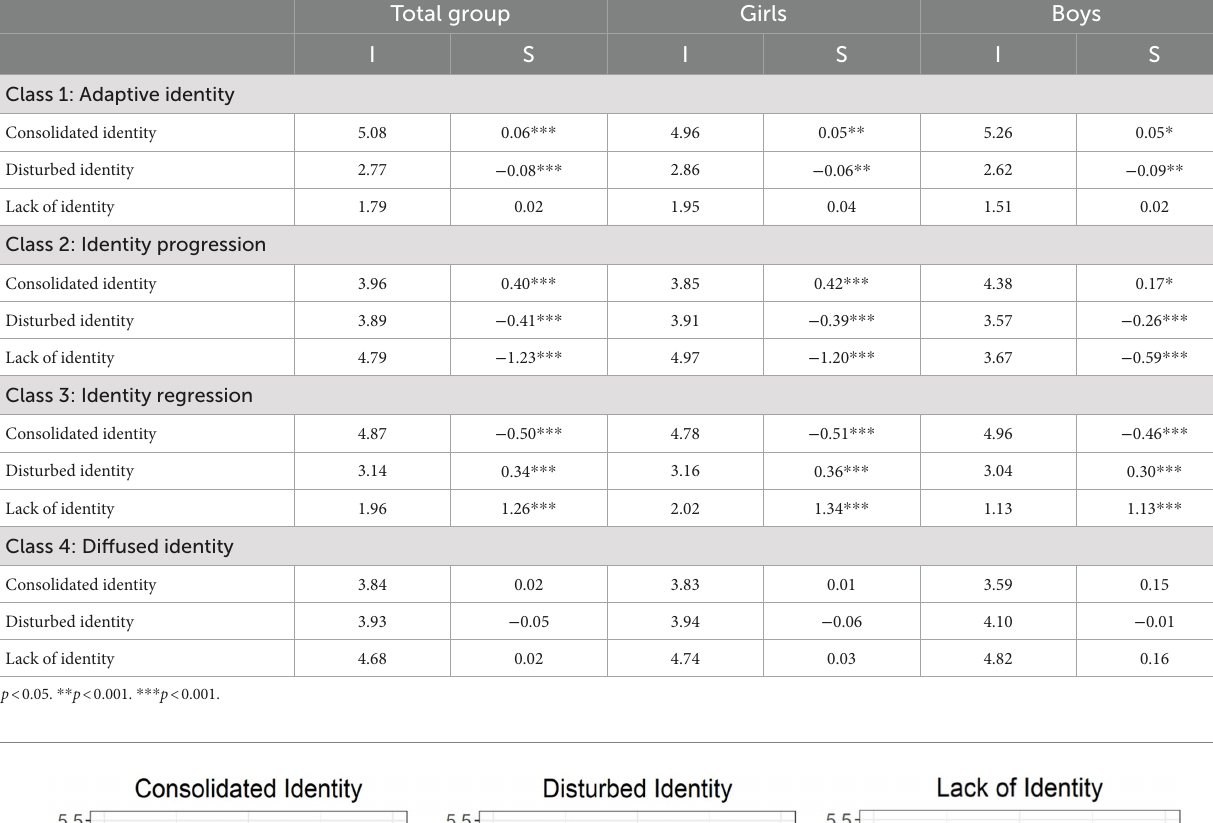
TABLE 5 Mean intercepts (I) and slopes (S) for the four-class solution for the total group, girls, and boys.